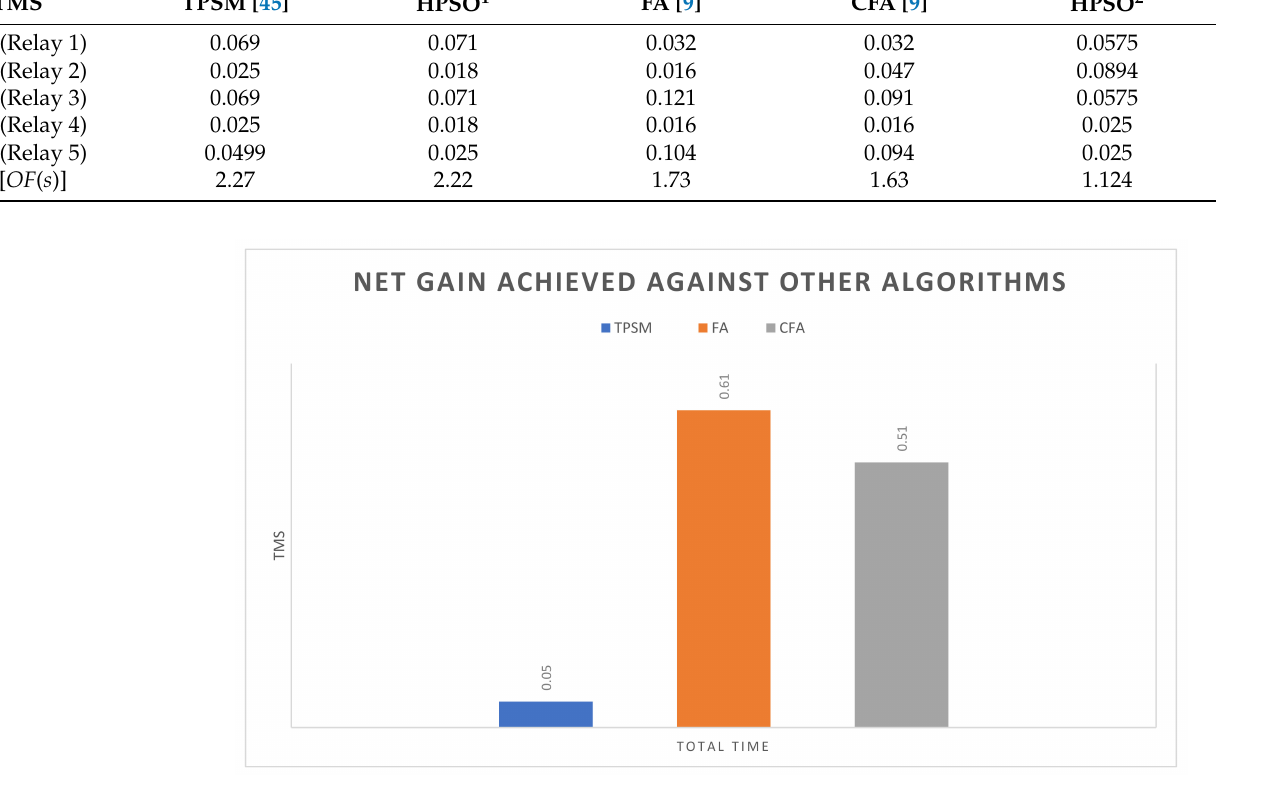
Figure 7. Comparison analysis of HPSO with other algorithm (Case